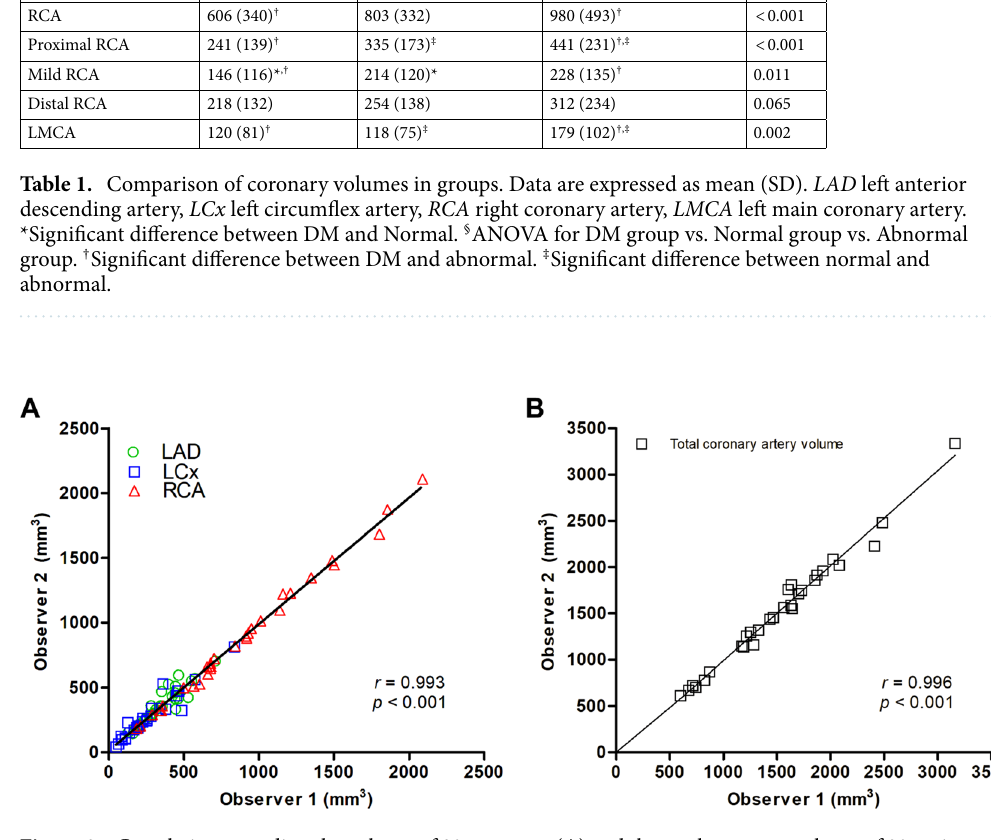
Figure 2. Correlation regarding the volume of 89 segments ( A ) and the total coronary volume of 29 patients ( B ) between two observers. Abbreviations: LAD left anterior descending artery, LCX left circumflex artery, RCA right coronary